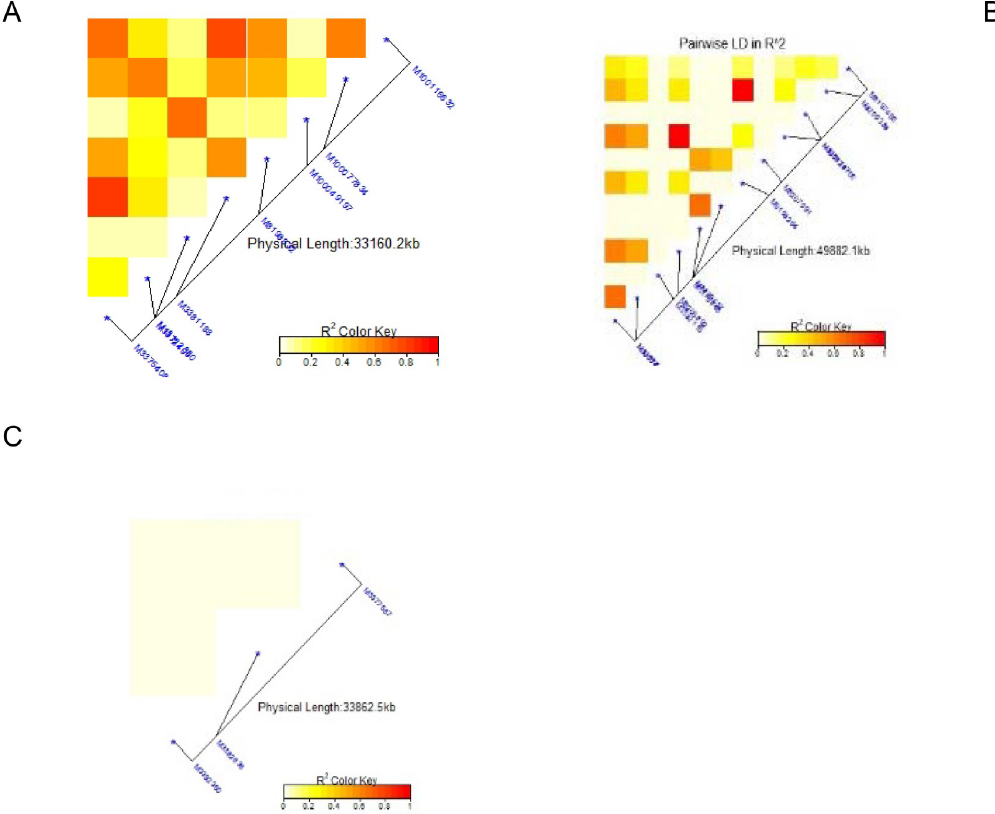
Fig 8. Summary of local LD among markers with significant marker trait associations of 99 common bean genotypes. Note: A = Bean fly damage severity (BDS), B = Pupa count (PC), C = Plant mortality rate (PMR). The R 2 colour key indicates the degree of significant